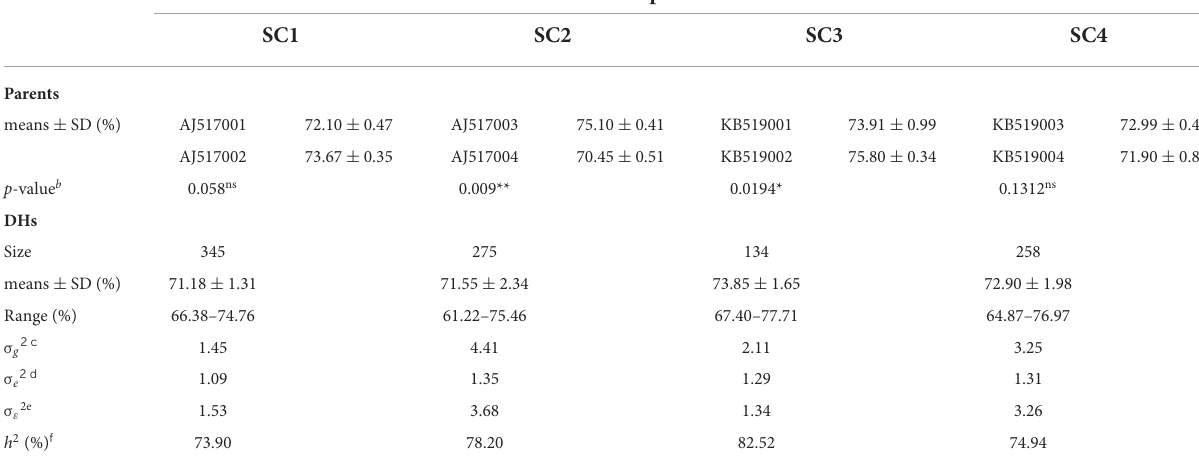
TABLE 1 Phenotypic performance, variance, and broad-sense heritability of starch content (SC) in the four double-haploid (DH) populations. Trait